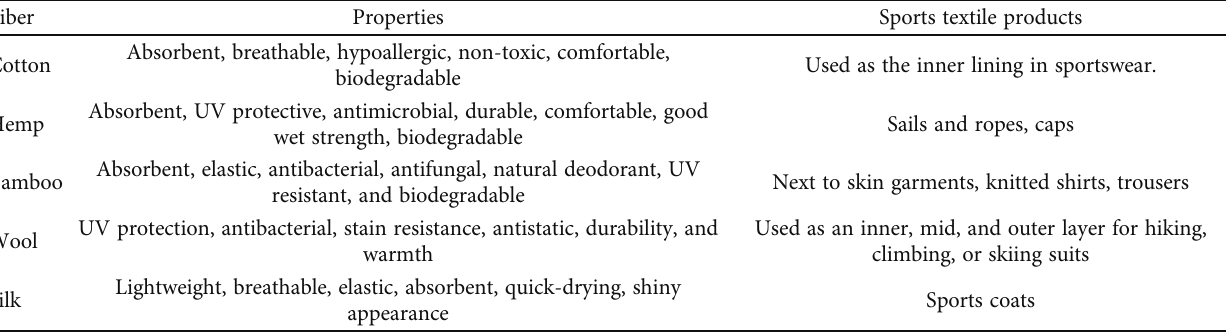
Figure 8: Working principle of outlast fi ber [65]. Table 2: Natural fi bers properties and their applications in sports textile products